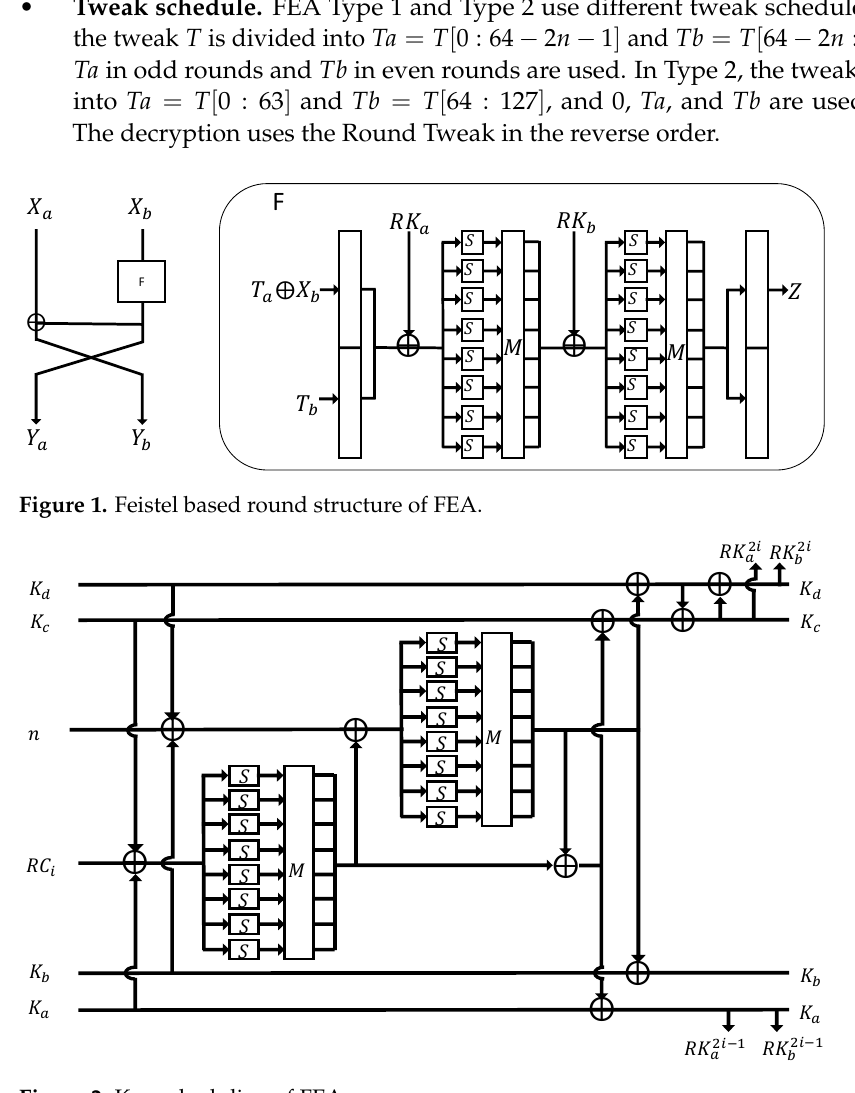
Figure 2. Key scheduling of